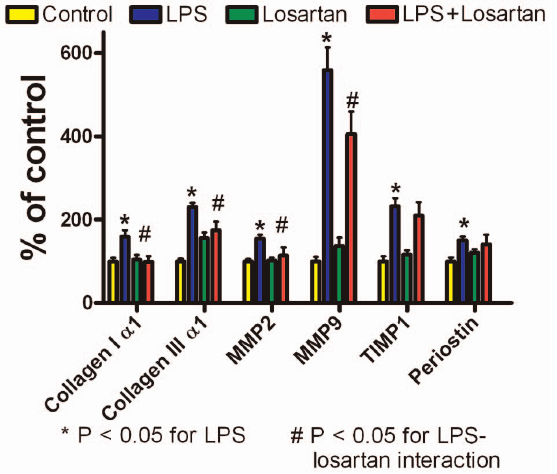
Figure 11. LPS activation of fibrosis-related genes attenuated by AT 1 R inhibitor losartan. Expression of fibrosis-related genes in the left ventricle measured by QRT-PCR (mean + SEM) after 15 weeks of weekly i.p. injections of saline (control, n=7), LPS (10 mg/kg, n=6), saline with losartan (20 mg/kg/day in drinking water) (n=6), or LPS with losartan (n=5). LPS increased LV expression of fibrosis-related genes including collagen I a 1, collagen III a 1, MMP2, MMP9, TIMP1 and periostin (P , 0.05, 2 way ANOVA). Adding the AT 1 R inhibitor losartan to the drinking water prevented LPS-induced increases in collagen I a 1 and MMP2 and attenuated LPS-induced increases in collagen III a 1 and MMP9 (P , 0.05 for interaction between LPS and losartan), but had no effect on TIMP-1 or periostin. Losartan alone had no effect.